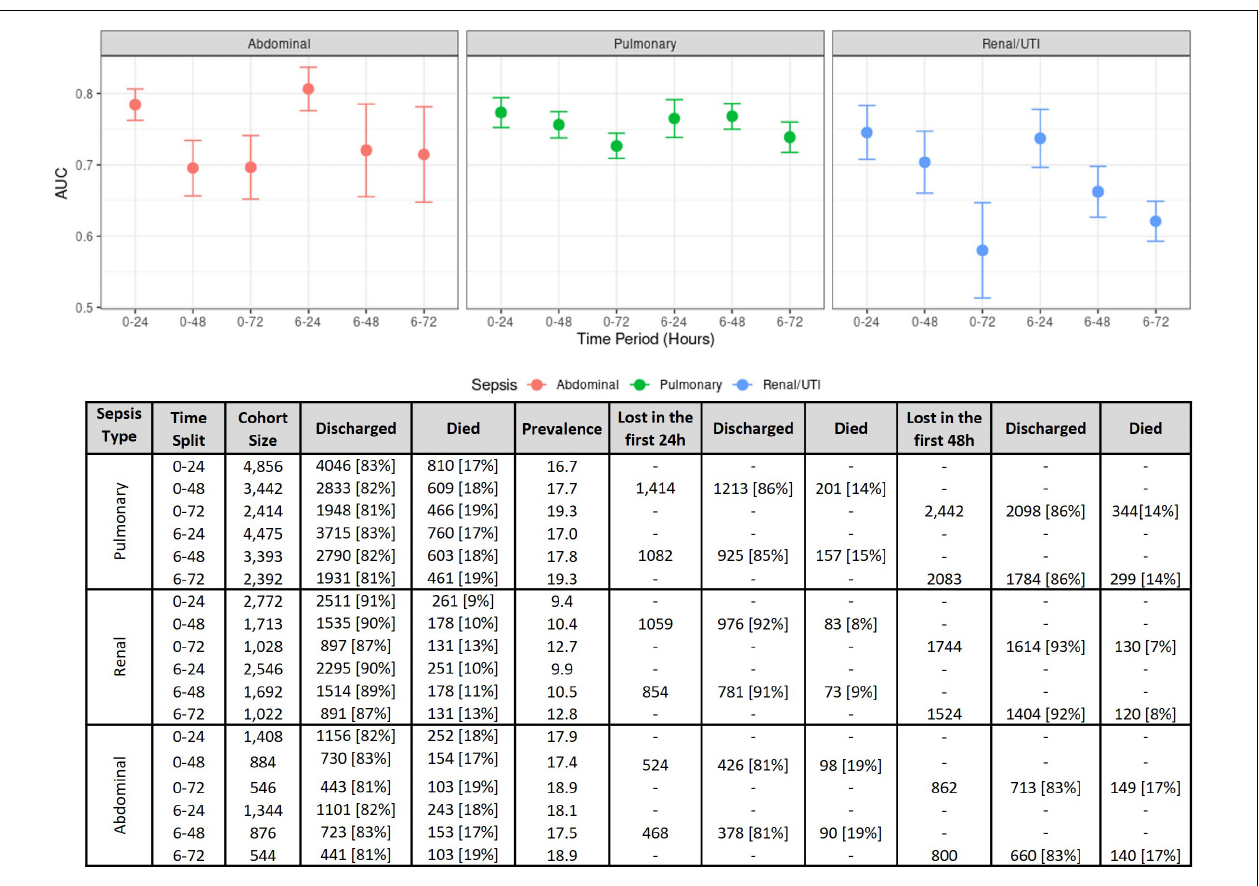
FIGURE 3 | Model performance measures on several time windows. (Top) Model performance comparisons as measured using the AUC for each sepsis group at several time intervals. The figure shows AUC means and confidence intervals estimated after the 10 repetitions of the outer cross-validation with logistic regression. (Bottom) Effects of different time windows on cohort size and mortality